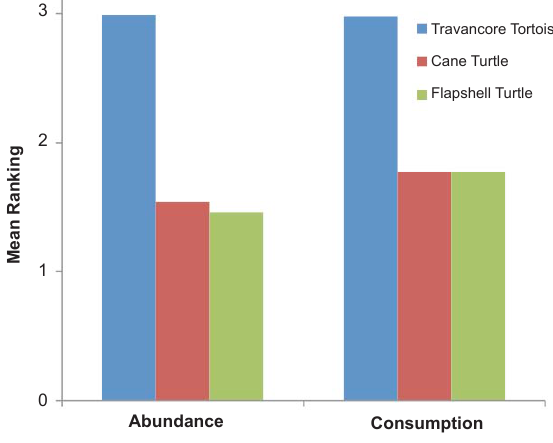
Figure 2. Overall mean ranking of abundance and consumption of the three chelonian species as per respondent